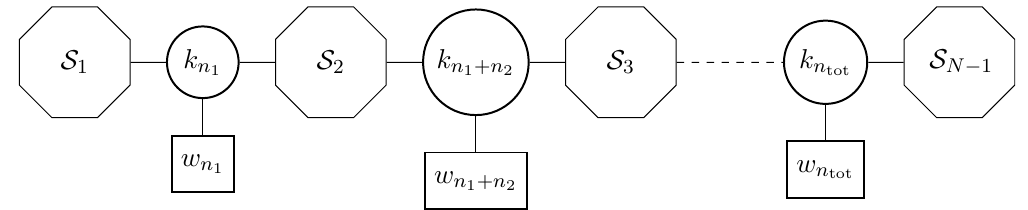
Figure 13 . General form for the Higgs branch quiver associated with M ( B; v ) in a SU( N ) theory. Each octagon S i denotes a superconformal sub-quiver with precisely n i (cid:0) 1 balanced nodes. The circular nodes denote the unbalanced gauge nodes, the total number of such nodes being N (cid:0) 2. Note that n tot = P N (cid:0) 1 n i = p N (cid:0) p 1 . The precise form of S i and expression for w n i =1